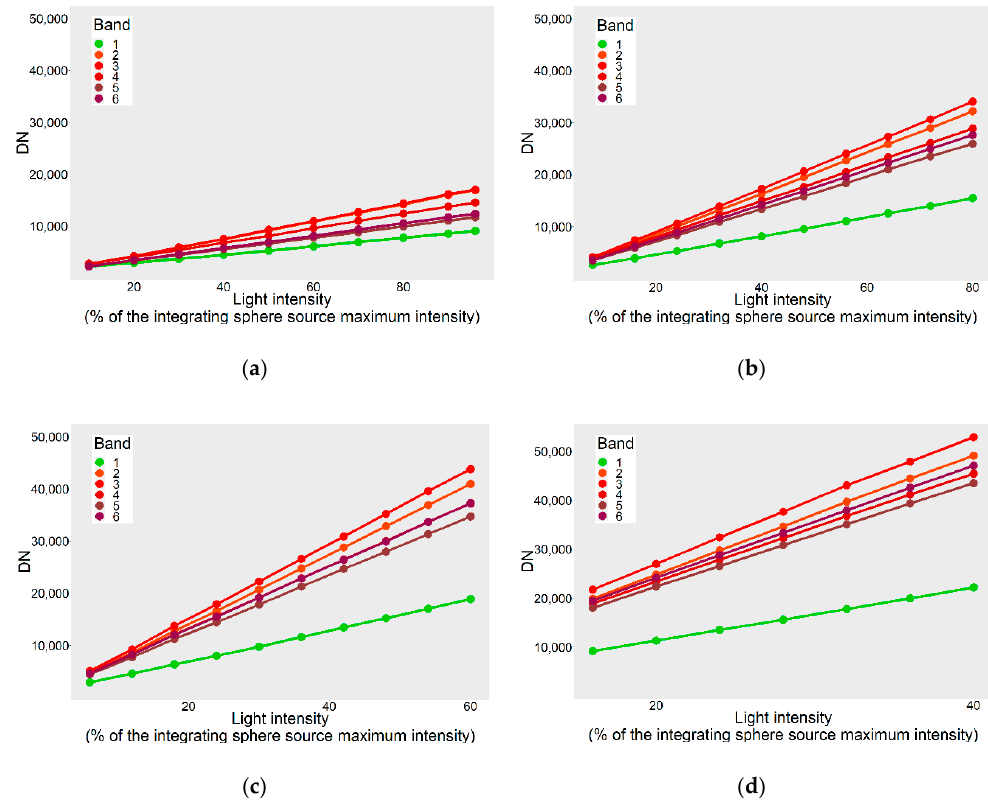
Figure 8. The linear response of the camera at different exposure times: ( a ) Exposure time 50 μ S; ( b ) Exposure time 250 μ S; ( c ) Exposure time 500 μ S; ( d ) Exposure time 1000 μ S. The sensor linearity was confirmed on each channel with a regression coefficient higher than 0.99.